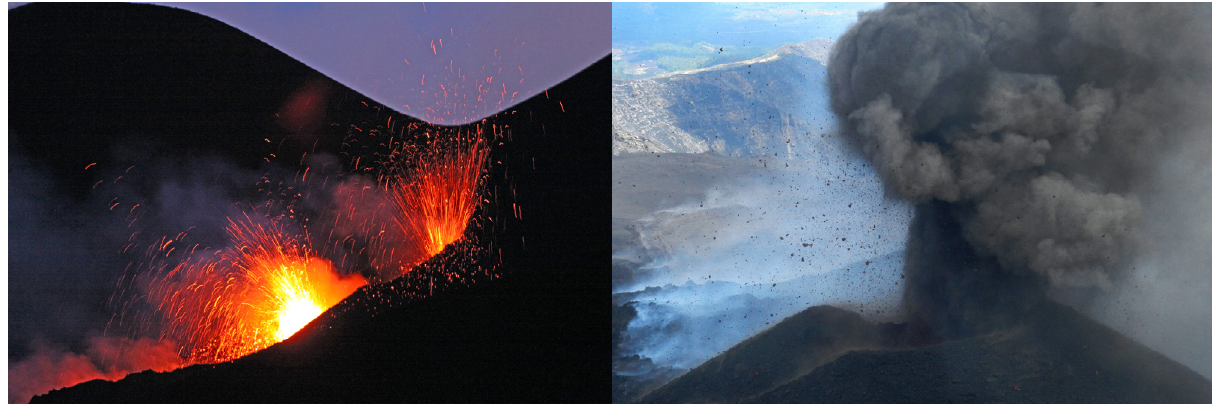
Figure 1. Two pictures showing the eruptive activity occurred in Mt. Etna volcano in the period June-November 2014. Pictures kindly pro- vided by (left) Dr. Jesús Ibáñez from Andalusian Institute of Geophysics; (right) by Dr. Boris Benke from INGV-Section of Catania-Osser- vatorio